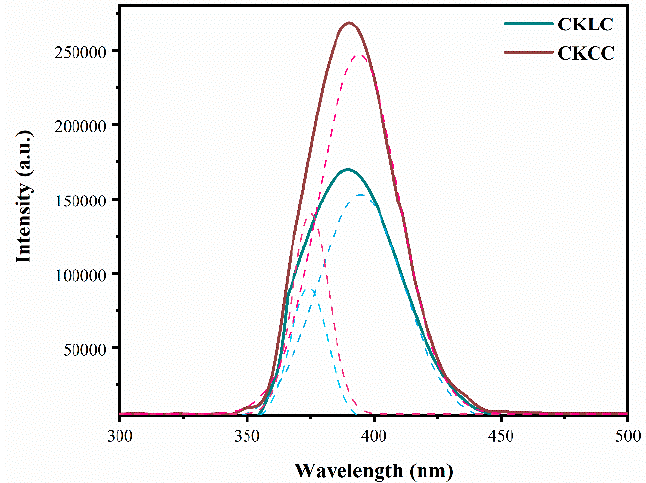
Figure 6. X-ray induced luminescence spectra of CKLC and CKCC crystals.